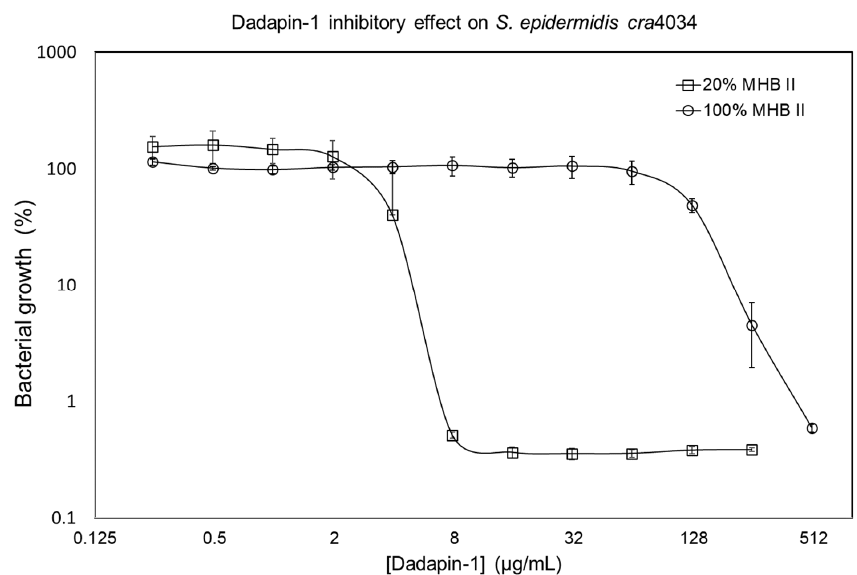
Figure 1. Inhibitory effects of Dadapin-1 on the growth of the S. epidermidis cra 4034 strain when the inoculum was prepared in undiluted MHB II medium (100% MHB II) and when the inoculum was prepared in 1:5 diluted MHB II medium (20% MHB II). The values of luminescence in RLU were